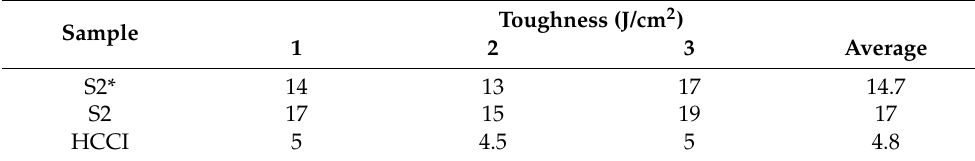
Table 3. Toughness of the studied bimetal and